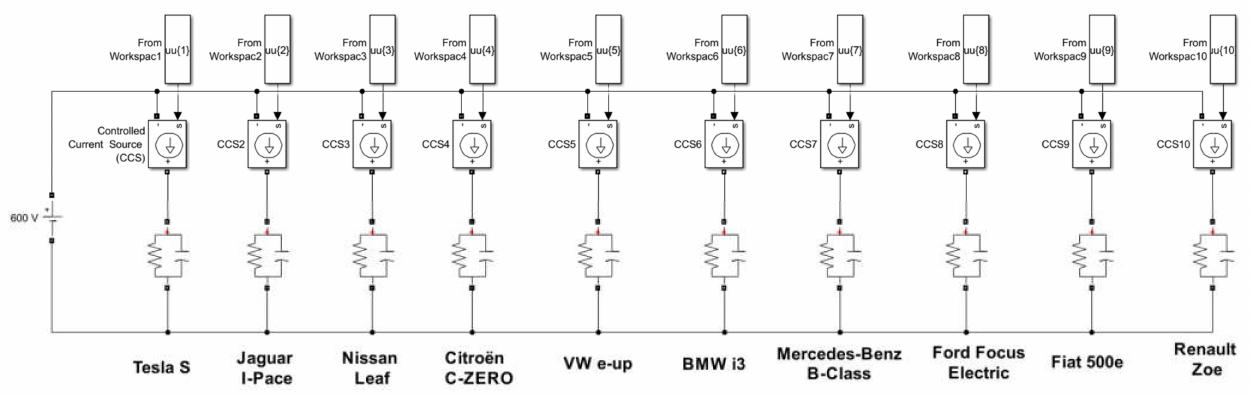
Figure 2. Circuit diagram with 10